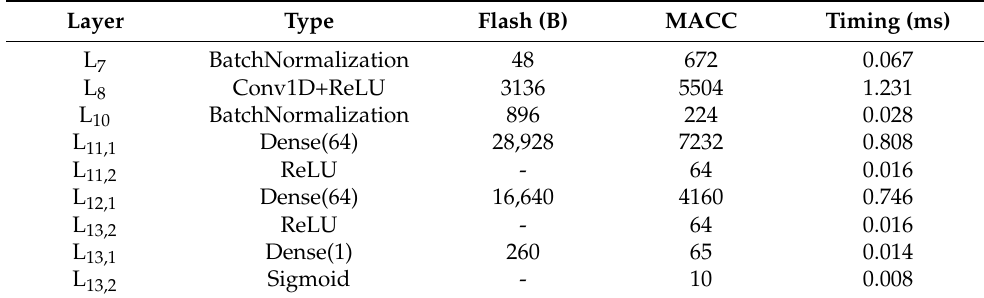
Table 8. CNN layers’ ROM utilization and MACC.